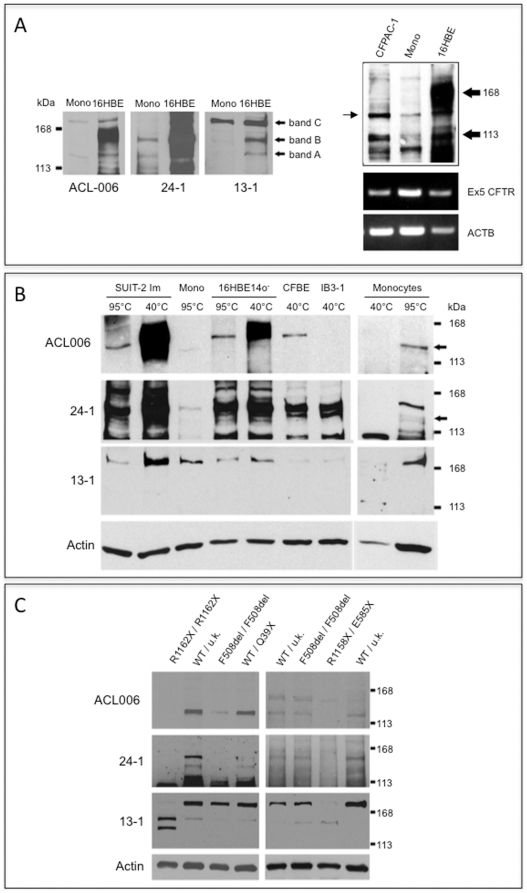
Expression of CFTR in epithelial cells and monocytes.
Panel A: Monocyte cell lysates were denatured at 95°C while epithelial cells were treated at 40°C before SDS-PAGE. The left panel shows the result after the incubation with the anti- CFTR antibody ACL-006, 24-1 or 13-1. Although in epithelial cells all the CFTR forms (A, B and C) are detected (although with a different pattern of reactivity depending on the type of antibody), in monocytes not all the bands are detected by the individual antibodies, although all of them are present as testified by the recognition of bands A, B and C by their combination. While band A is consistently detected by ACL-006 antibody in monocytes, detection of the other bands with this antibody is not reproducible in all the samples tested. On the right side of the panel the arrow indicates the less glycosylated form of CFTR (band A) expressed in 16HBE14o- cells, CFPAC-1 and monocytes (ACL-006 antibody). mRNA of CFTR as detected by RT-PCR is expressed by monocytes that express the same spliced isoform expressed by epithelial cells. Actin (ACTB) has been amplified as control. Panel B: Temperature-dependent detection of CFTR Effect of the denaturating temperature on the CFTR bands detected in epithelial cells and monocytes. A major band around 170 kDa (band C) is detected in both epithelial cells lines expressing wild-type CFTR (Suit 2 and 16HBE14o-) and in monocytes (13-1 antibody). CFBE41o− (CFBE) (F508del/F508del) cells express a single band corresponding to a core-glycosylated CFTR (band B, ACL-006 and 24-1 antibodies) while CFTR expression level in IB3-1 (W1282X/F508del) is below the detection limit of the assay for ACL-006 antibody but display a band using the 24-1 antibody. The incubation with ACL-006, 24-1 and 13-1 antibodies, reactive against a C- and a more N-terminal epitope (13-1), when analyzed together, identify all the glycosylated forms in our assay only when the most appropriate temperature is utilized (40°C for epithelial cells and 95°C for monocytes). Of note is the loss of CFTR signal in monocytes treated at 40°C associated to a reduction of immunoreactivity of anti-actin antibody used to demonstrate equal protein load (last two lanes, right). Panel C: Western blotting with the indicated antibodies on lysates of monocytes derived from patients with the indicated genotypes. Note that the bands corresponding to a full length CFTR present in wild-type (WT) or obligate heterozygotes (WT/Q39X) are missing in monocytes derived from patients homozygous for nonsense mutations (13-1 antibody). Patients carrying one or two F508del alleles express a much fainter band. Actin expression is shown to demonstrate equal protein load.